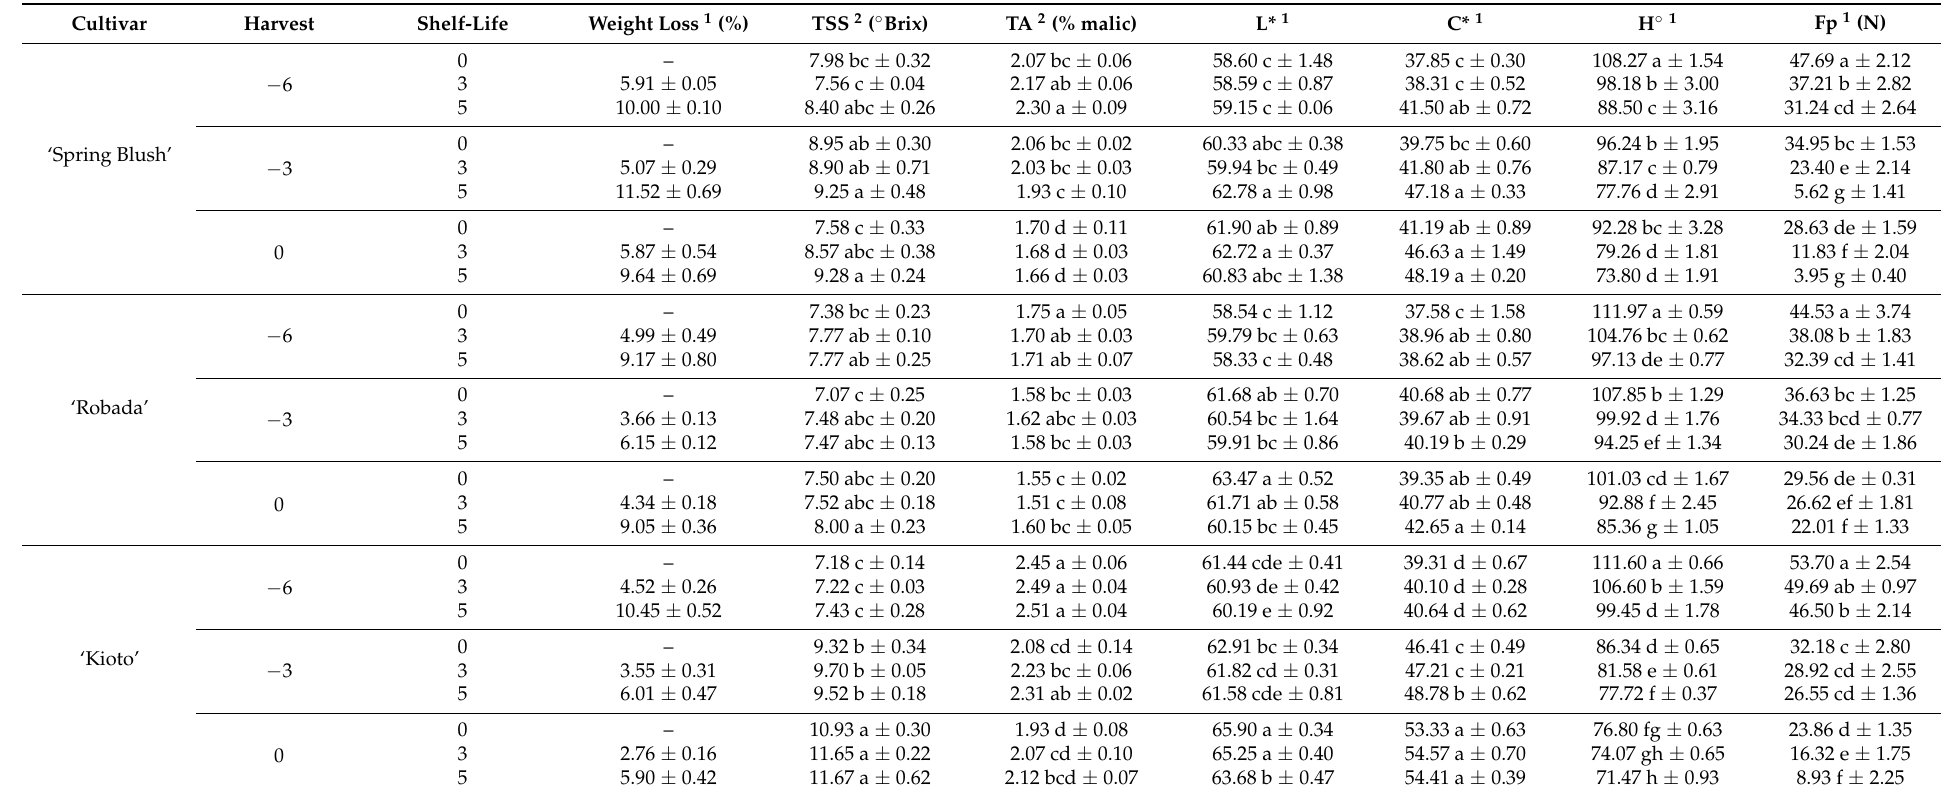
Table 2. Physico-chemical parameters of the apricot cultivars at harvest and during